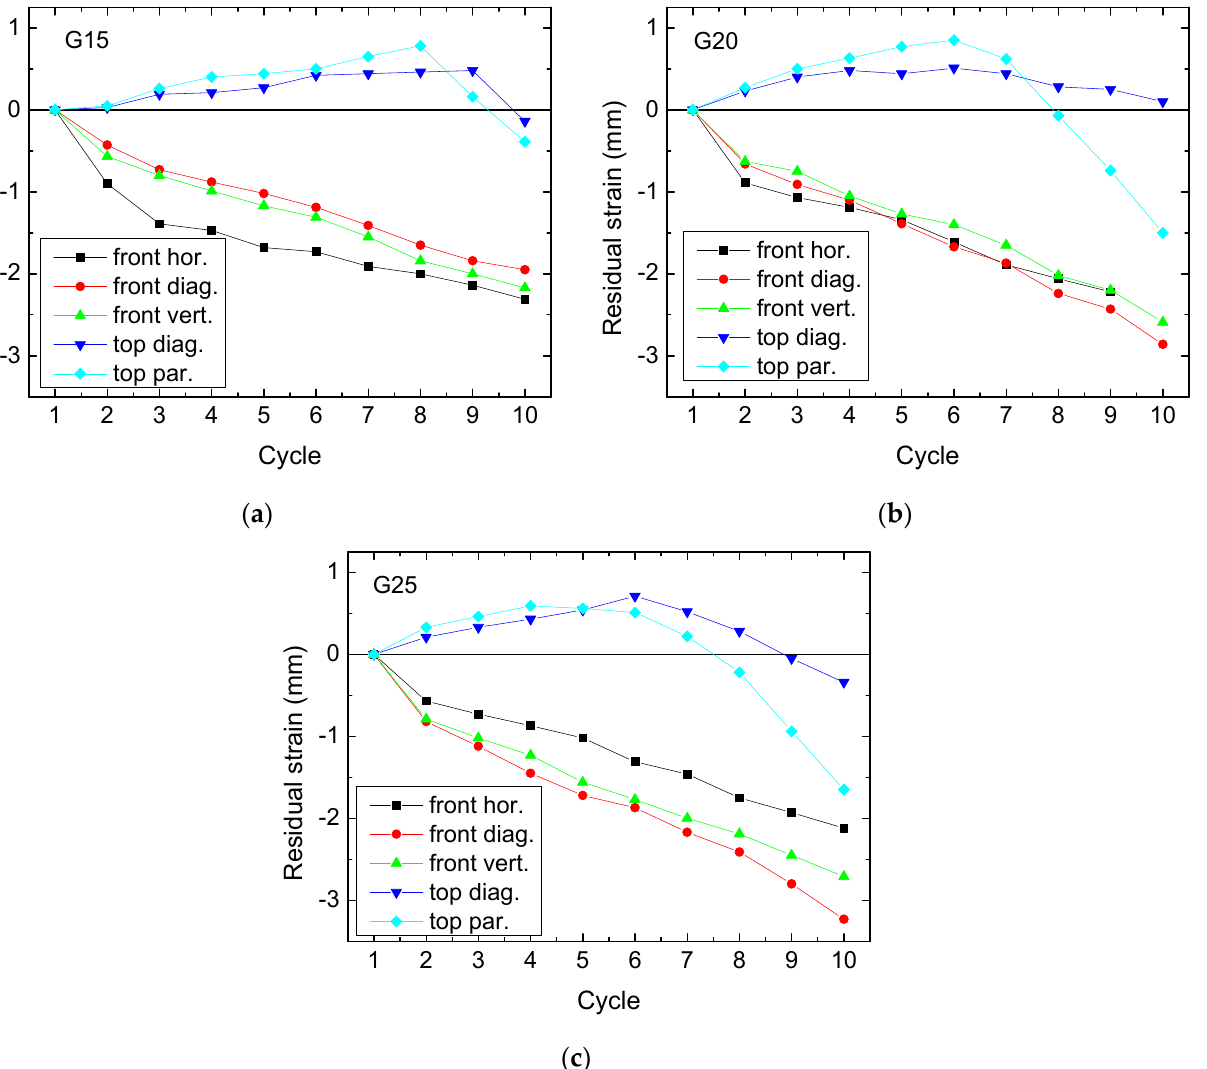
Figure 8. Cycle-dependent residual strain, measured for different sets of samples: ( a ) G15; ( b ) G20; ( c ) G25.